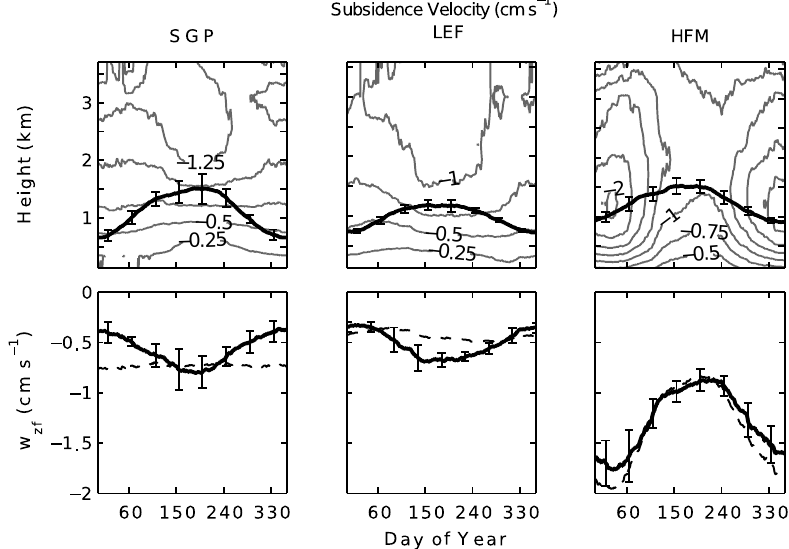
Fig. 7. Top: Mean annual cycle of subsidence velocity (where w < 0) calculated from ECMWF data (years 2001-2007), contoured every 0.25cms − 1 , overlaid with CT/TM5 90-day running average maximum daily mixed layer height (error bars indicate standard deviation of the mean). Below: Subsidence velocity at the 90-day running average mixed layer top ( w zf ) (solid line) and at the annual average (constant) mixed layer depth (dashed line).